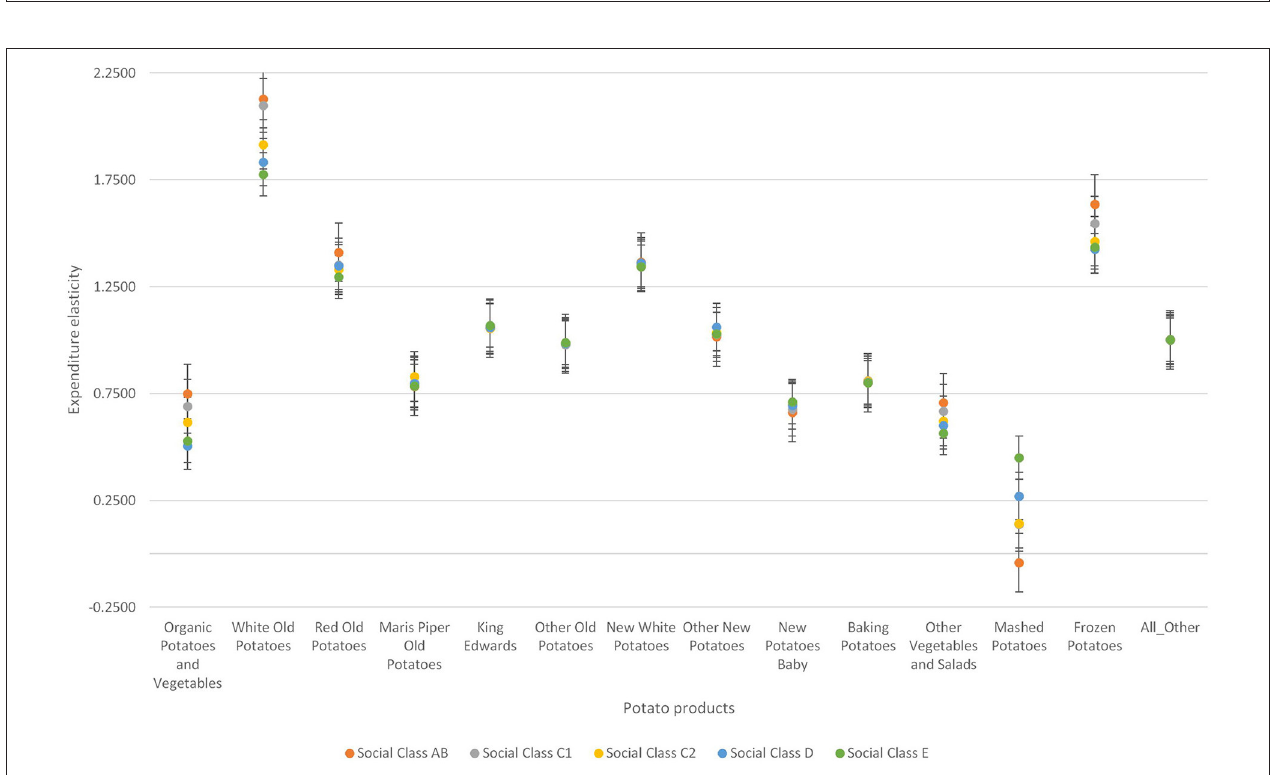
FIGURE 3 | Variations in expenditure elasticities across different social class in the UK.